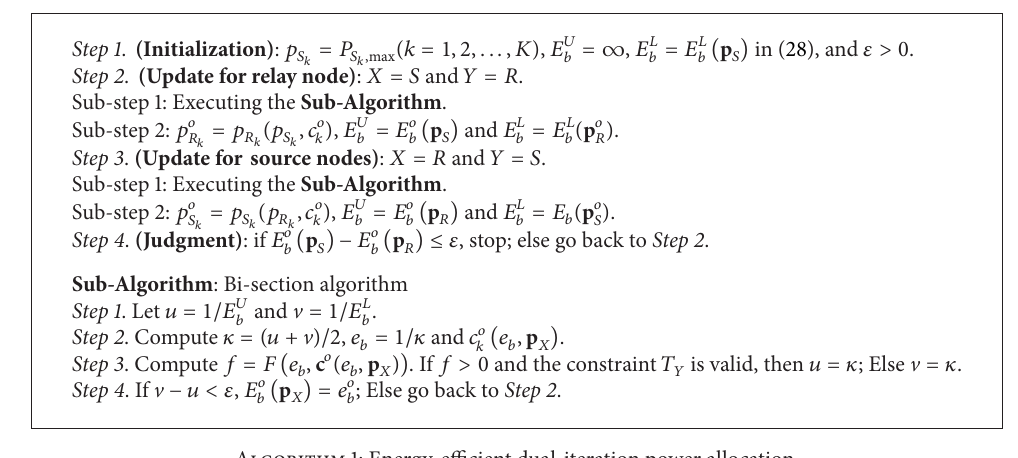
Algorithm 1: Energy-efficient dual-iteration power